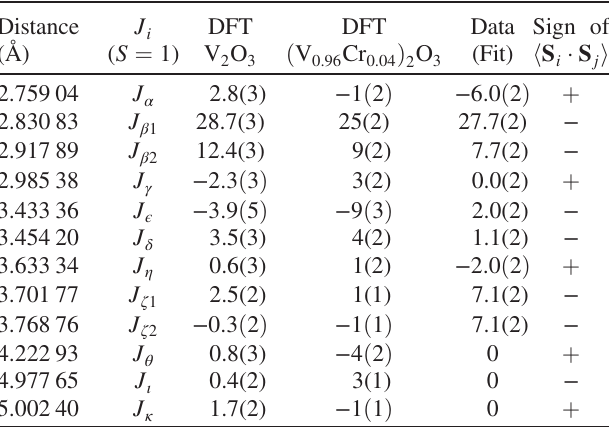
TABLE I. Magnetic exchange constants (in units of meV) for Þ Cr 0 the AFI phase in ð V 0 2 O 3 , obtained from both DFT . 96 . 04 calculations and direct fitting of the neutron data as described in the main text. Column 6 gives the sign of the indicated correlation h S i for the AFI structure [Fig. 1(c)]. The consistent negative · S i j sign of the product between columns 5 and 6 indicates an unfrustrated magnet.